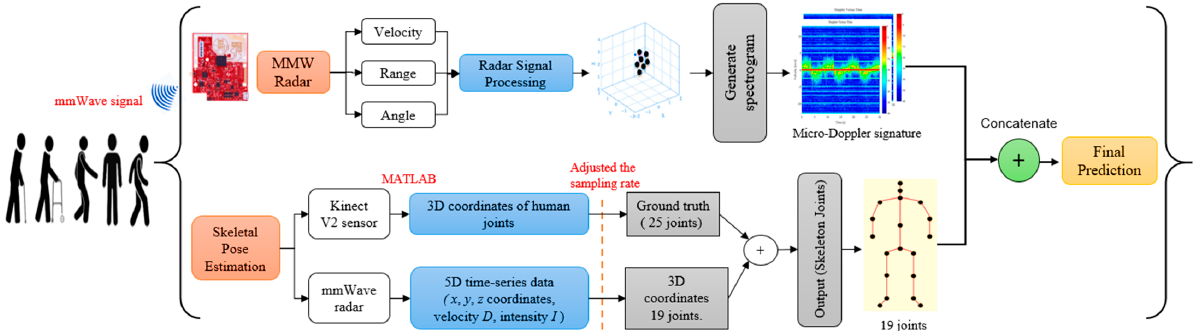
Figure 1. A flow diagram of the MMW radar gait system.